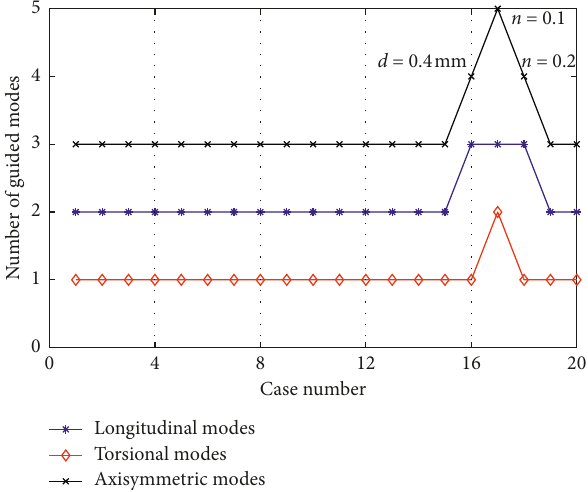
Figure 10: Comparison of the guided wave mode